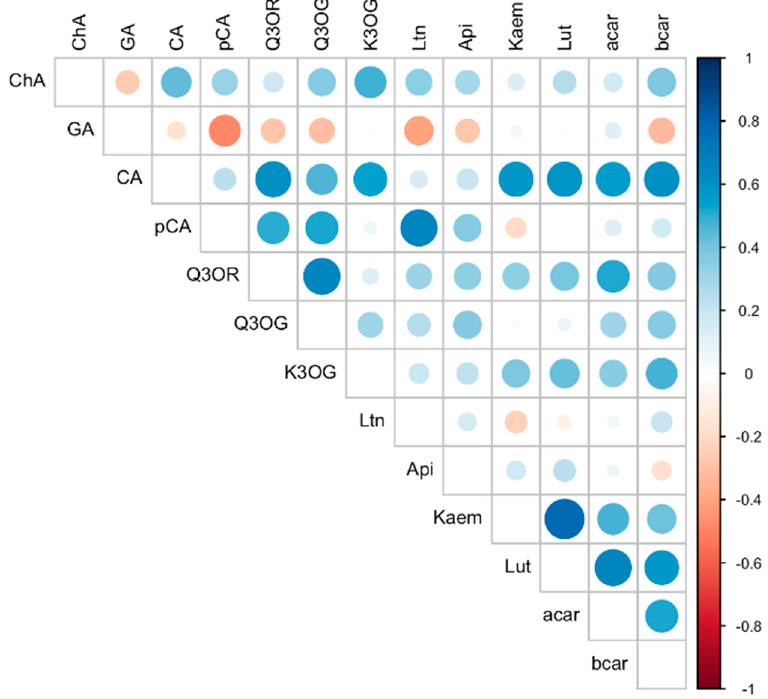
Figure 4. Pearson’s correlations between the concentrations of the individual phenolics and carotenoids identified in the carrot roots. Color (blue/red) and color intensity correspond to the direction and the strength of the correlation, while the circle size corresponds to statistical significance ( p -value). ChA, chlorogenic acid; GA, gallic acid; CA, caffeic acid; pCA, p -coumaric acid; Q3OR, quercetin-3- O -rutinoside; Q3OG, quercetin-3- O -glycoside; K3OG, kaempferol-3- O -glycoside; Ltn, luteolin; Api, apigenin; Kaem, kaempferol; Lut, lutein; α car, α -carotene; β car, β -carotene.